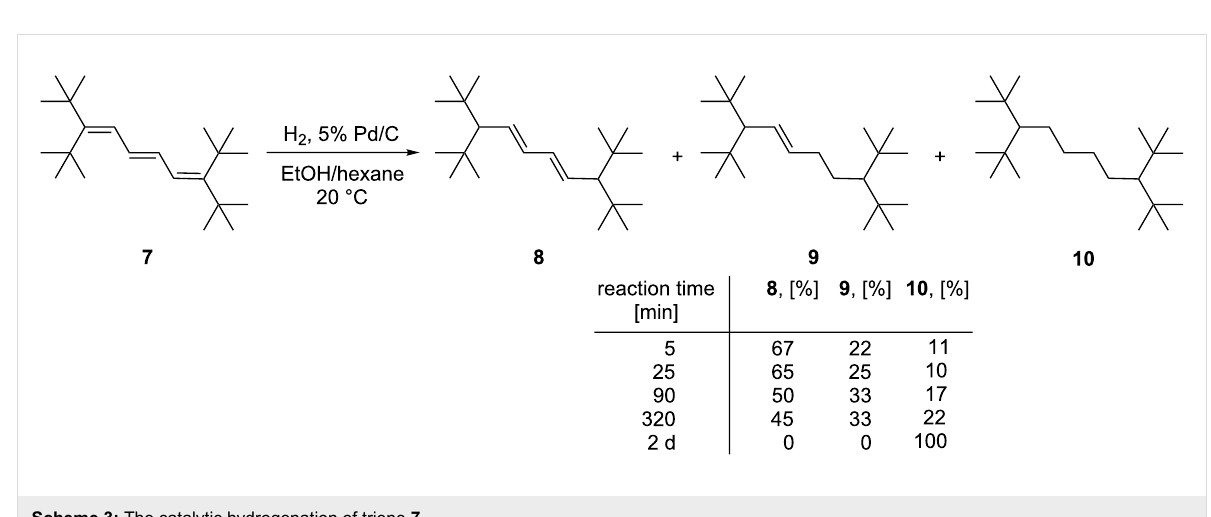
Scheme 3: The catalytic hydrogenation of triene 7